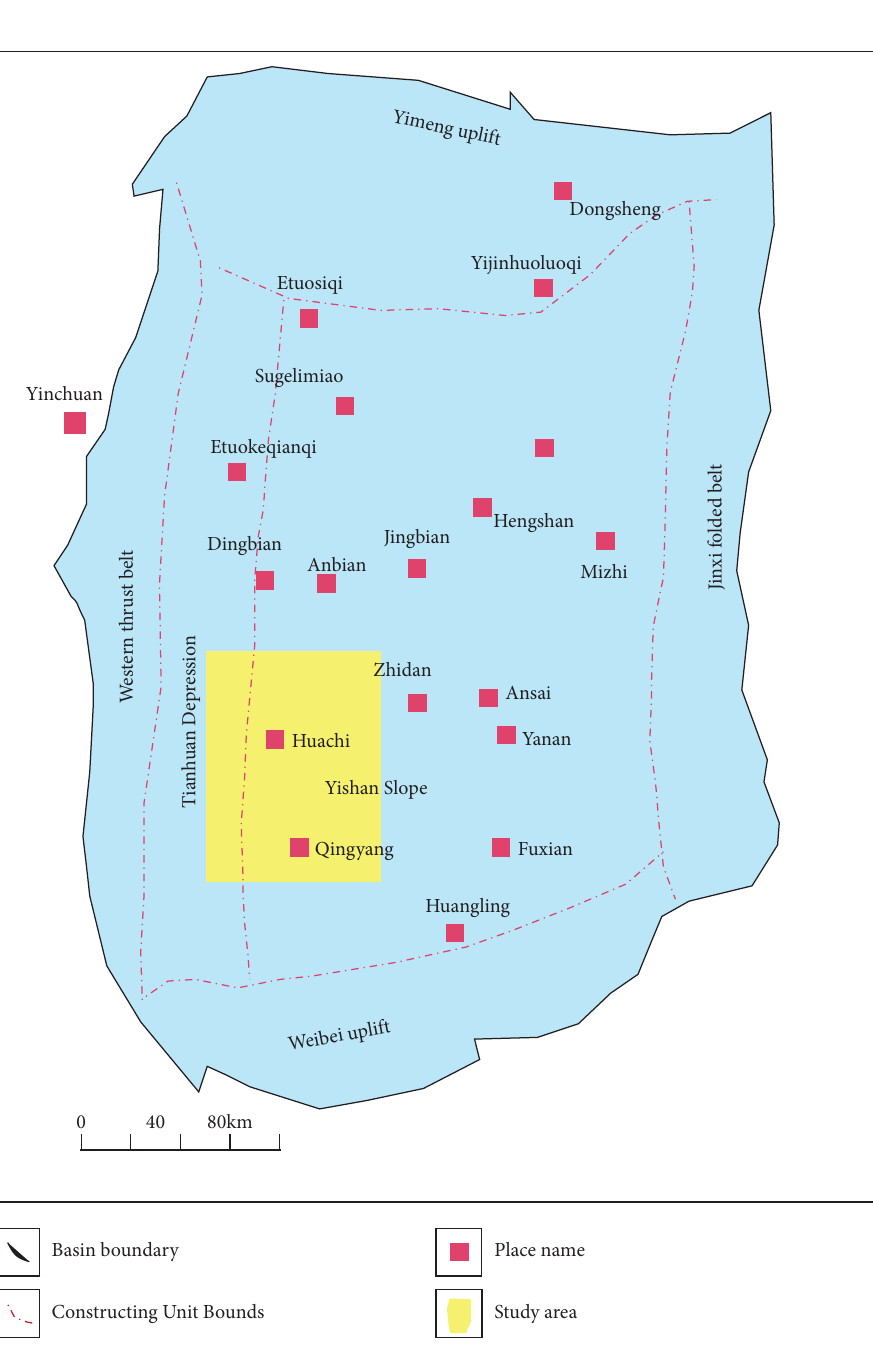
Figure 1: Location of the study